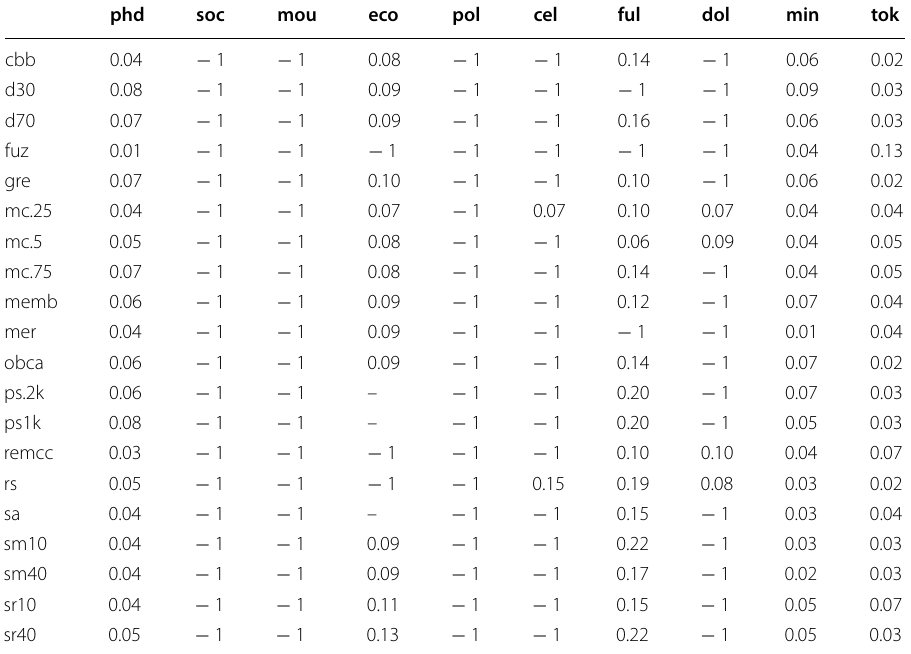
Here, 1.0 means that the network could not be considered fractal or there were too few datapoints. The hyphens indicate − the lack of data due to the abort of the process